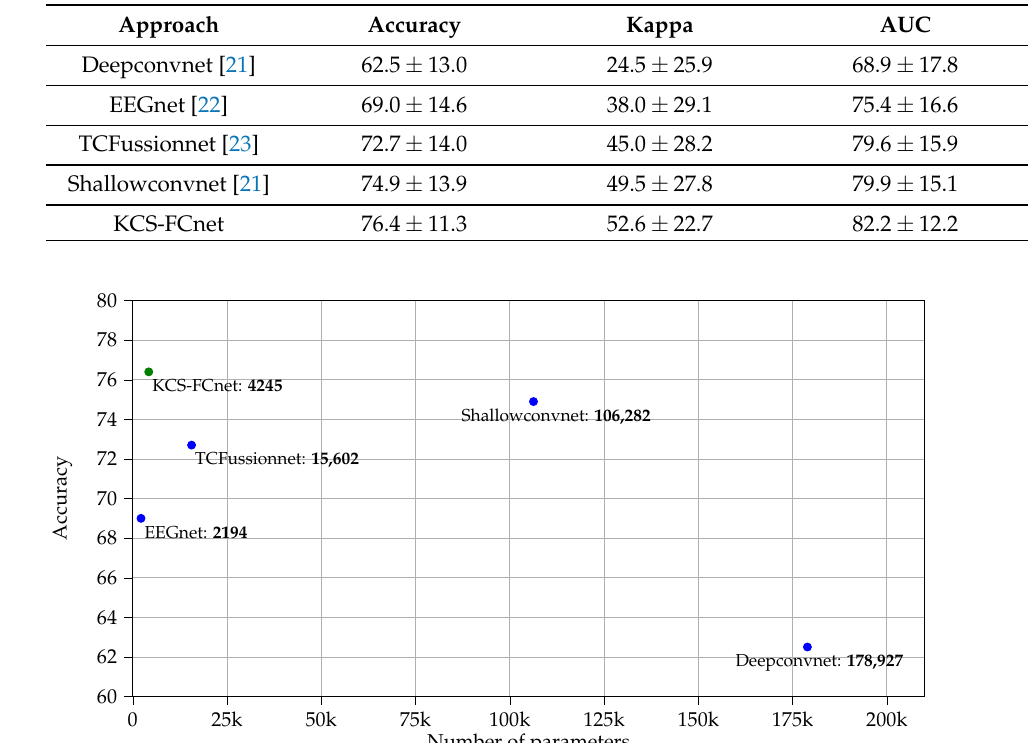
Table 3. Method Comparison results regarding the average MI classification for the Giga database.